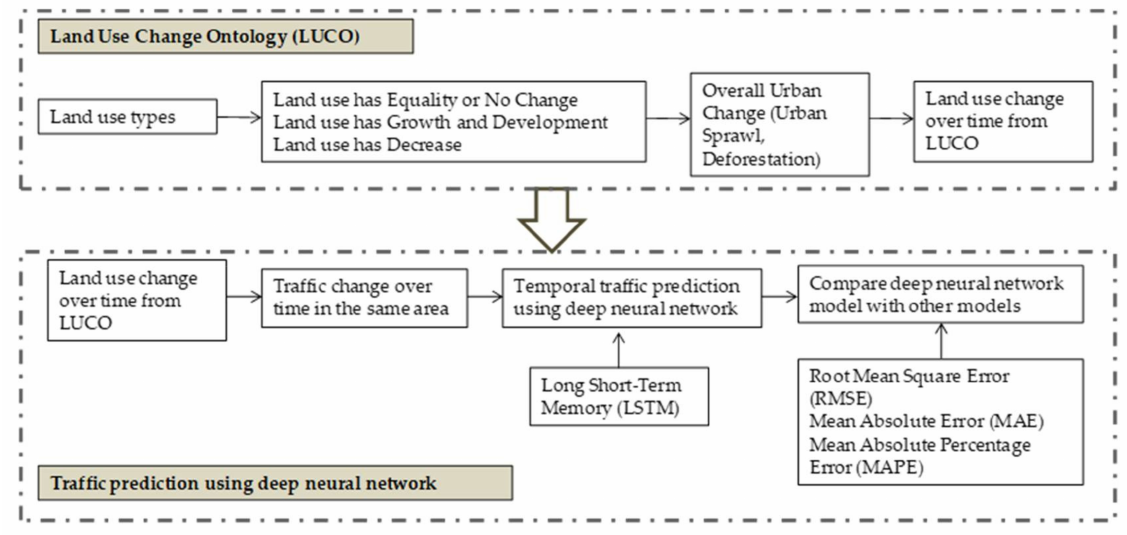
Figure 2. Overall methodology.